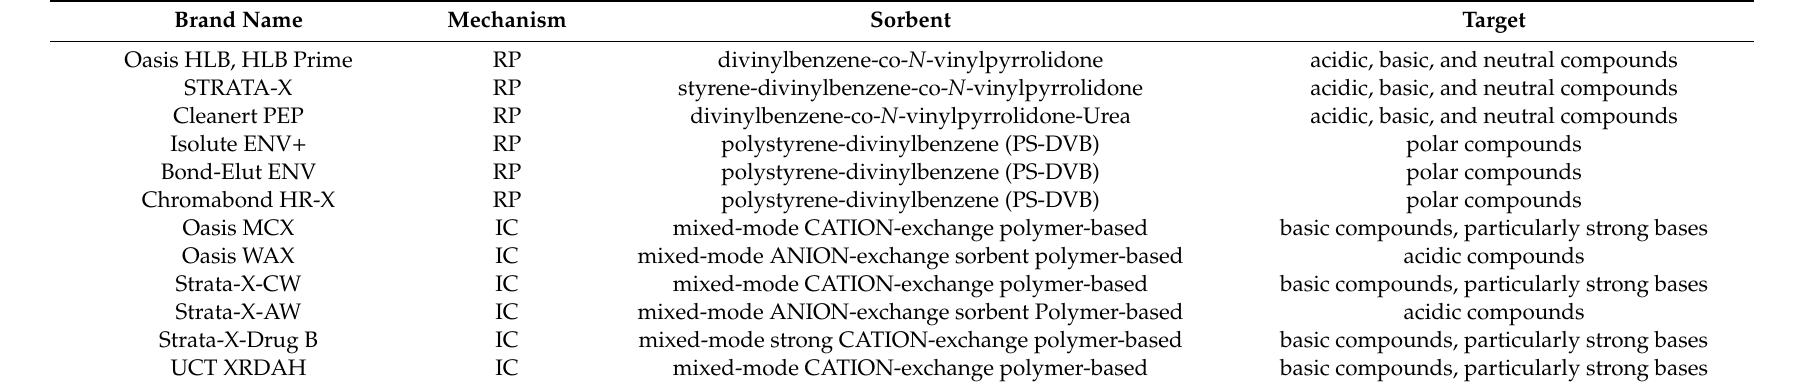
Table 2. Mechanism, type of sorbent and target of the most used brand name of o ffl ine